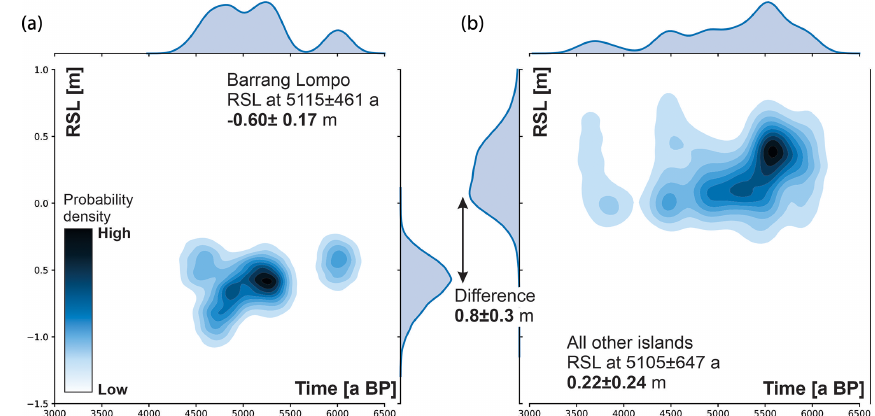
Figure 9. Joint plot showing bivariate (central plot) and univariate (marginal axes) distribution of RSL data points at Barrang Lompo (a) and all the other islands surveyed in this study and in Mann et al. (2016) (b) . Darker blue areas in the central plots indicate a higher density of RSL point therefore darker colors indicate a higher probability of RSL at the given time. The Jupyter notebook used to create this graph is available in Rovere et al.